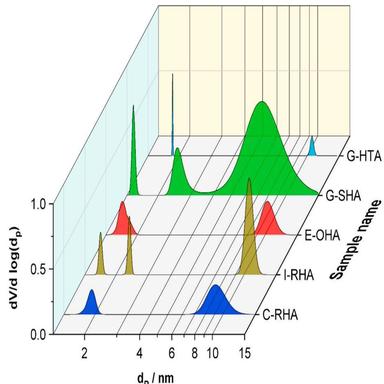
PSDs (determined by PALS after processing with MELT); C-/I-RHA: rice husk ash (Cambodia/Italy), E-OHA: oat husk ash (Europe), G-SHA: spelt husk ash (Germany), G-HTA: horsetail ash (Germany).